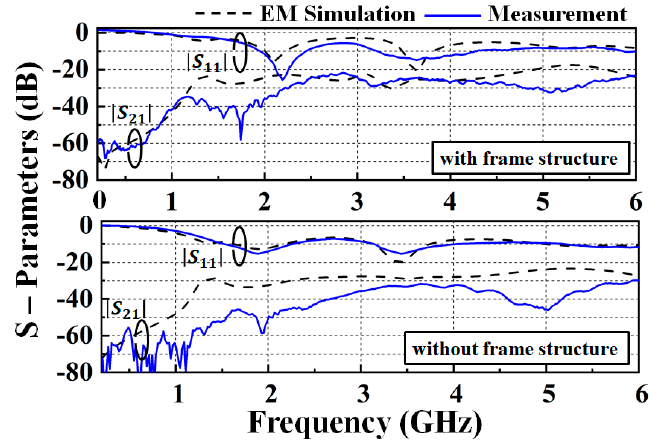
Figure 4. Surface current distributions of the dual-band transparent antennas ( a ) with the frame structure and ( b ) without the frame structure.